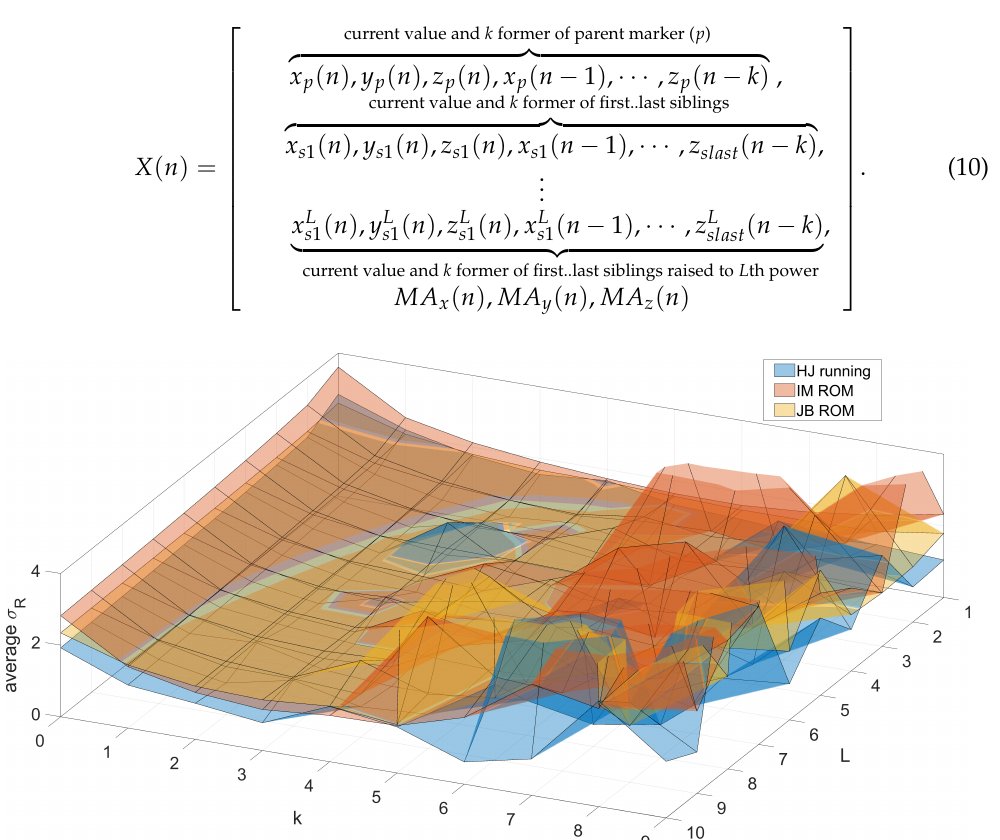
Figure 7. Predictor parameter tuning with preliminary data for three subjects, quality as stan- dard deviation averaged over all markers; the tuned parameters: L —polynomial order, k —context size